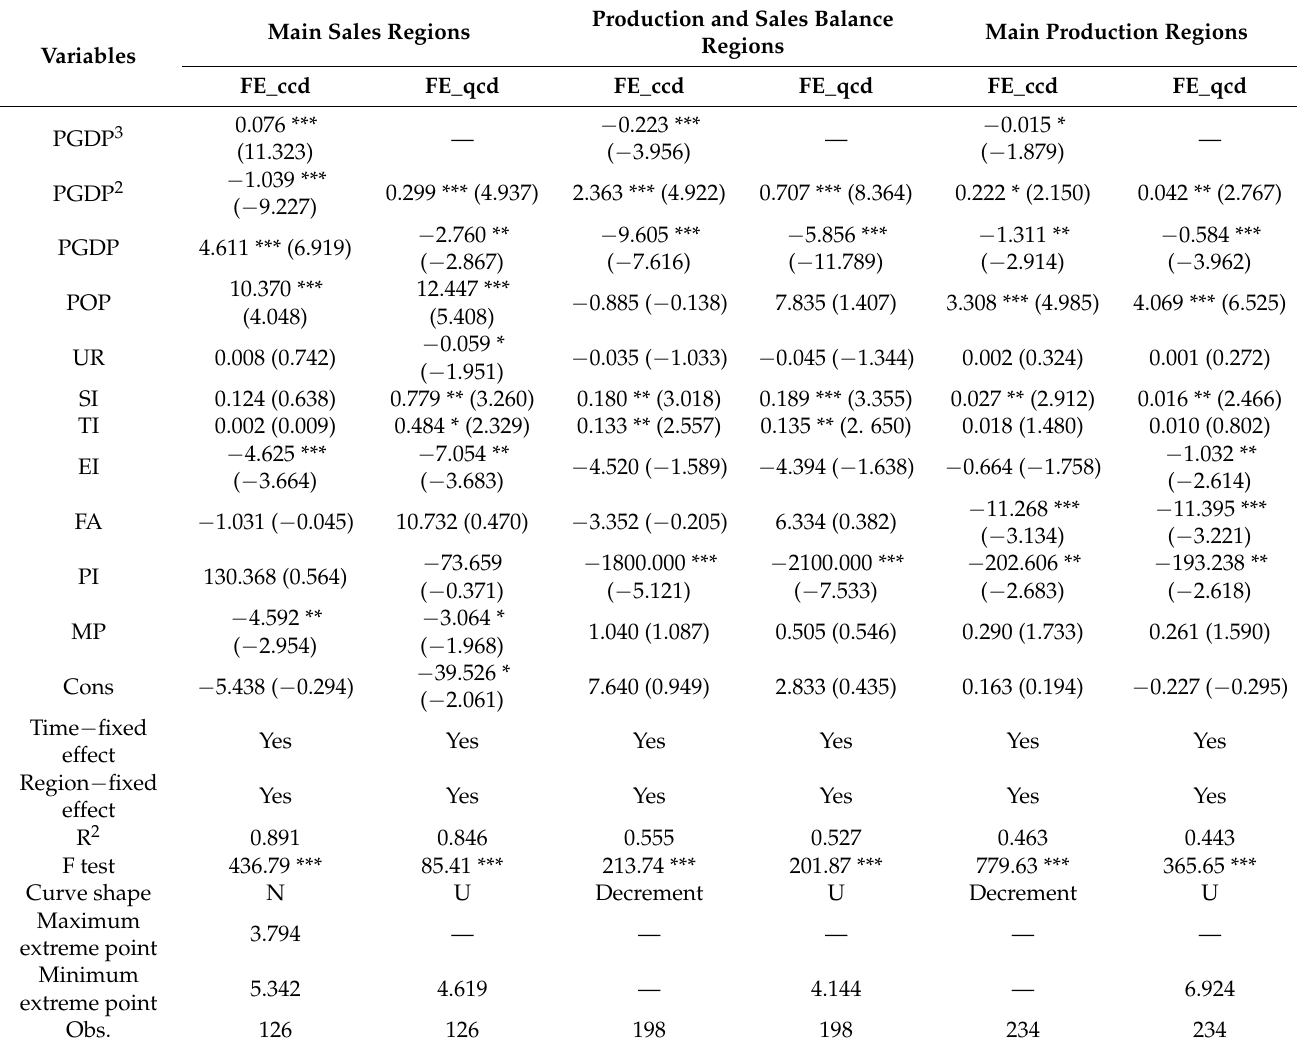
Table 11. Estimation results of different grain production and sales